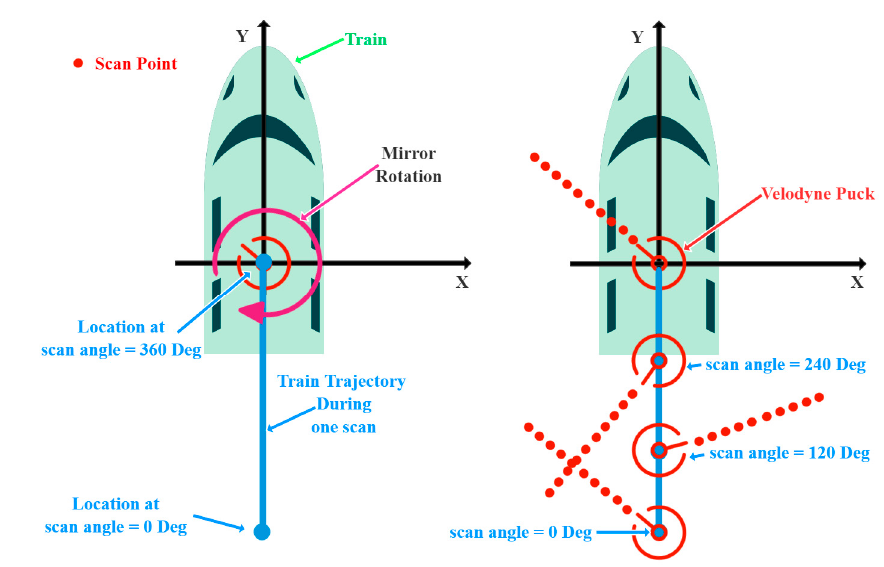
Figure 4. Velodyne puck scan distortions introduced by the train motion.